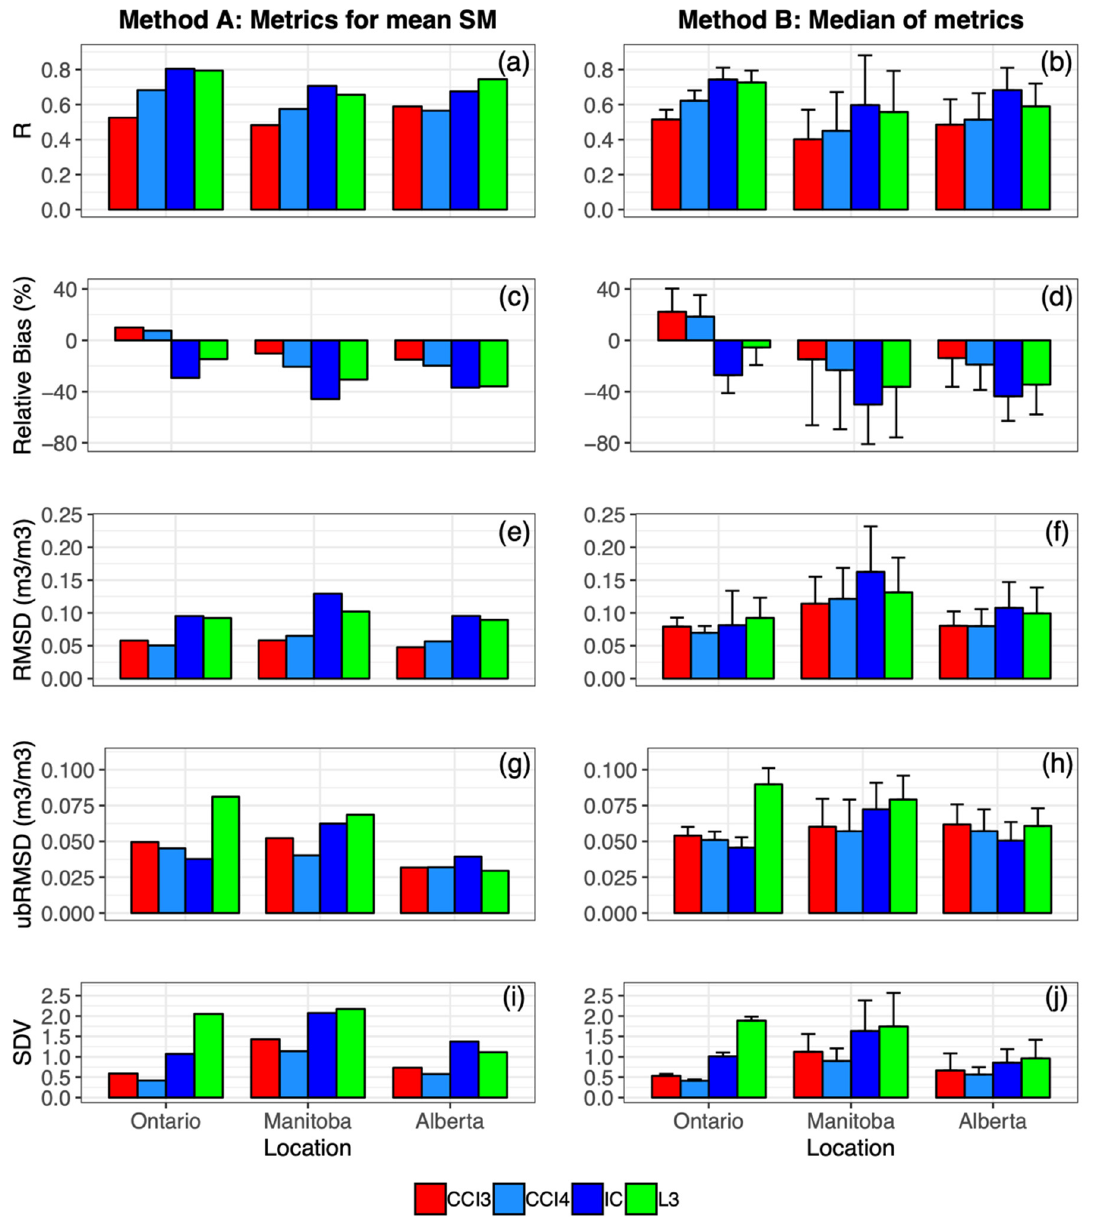
Figure 4. SM evaluation metrics – ( a – b ) R, ( c – d ) Relative Bias, ( e – f ) RMSD, ( g – h ) ubRMSD and ( i – j ) SDV) – for the Ontario, Manitoba and Alberta networks for the period 2012 to 2014. The two methods used for statistical comparison are the method A: metrics for mean SM calculated from all stations in each network ( left column ) and method B: the median of metrics for individual stations in a network ( right column ). The error bars for the median of metrics plots represent the standard deviation across the stations in each network.